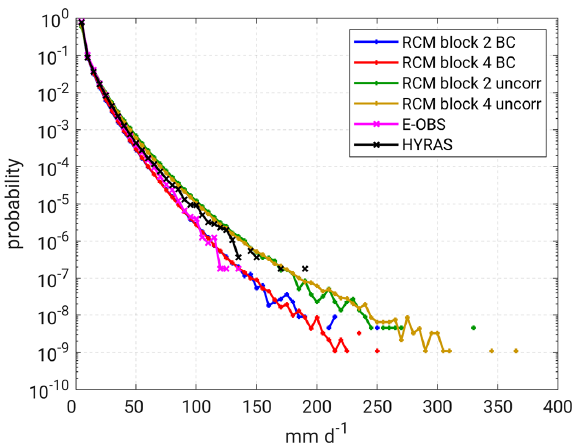
Figure 3. Intensity–probability curve (IPC) of daily rainfall totals within the Rhine basin for LAERTES-EU data blocks 2 and 4, HYRAS, and E-OBS. For LAERTES-EU, the IPCs for the original data set (uncorr) and the bias-corrected data set (BC) are shown.